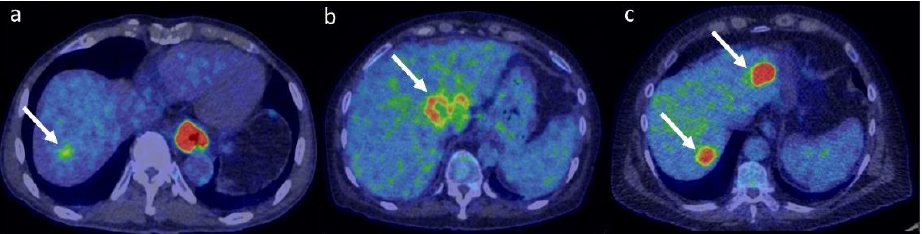
Figure 5. Fused 18 F-FDG PET/CT representative images of HCC ( a ), ICC ( b ) and liver metastases from colorectal cancer ( c ). Note the relatively mild uptake in HCC (SUVmax 4.2 g/mL), the ring-shaped uptake in ICC (SUVmax 7.8 g/mL) and the high uptake in metastatic lesions (SUVmax 15.3 g/mL). PET colour scale 0–7. The patient represented in panel ( a ) had a concomitant oesophageal cancer.